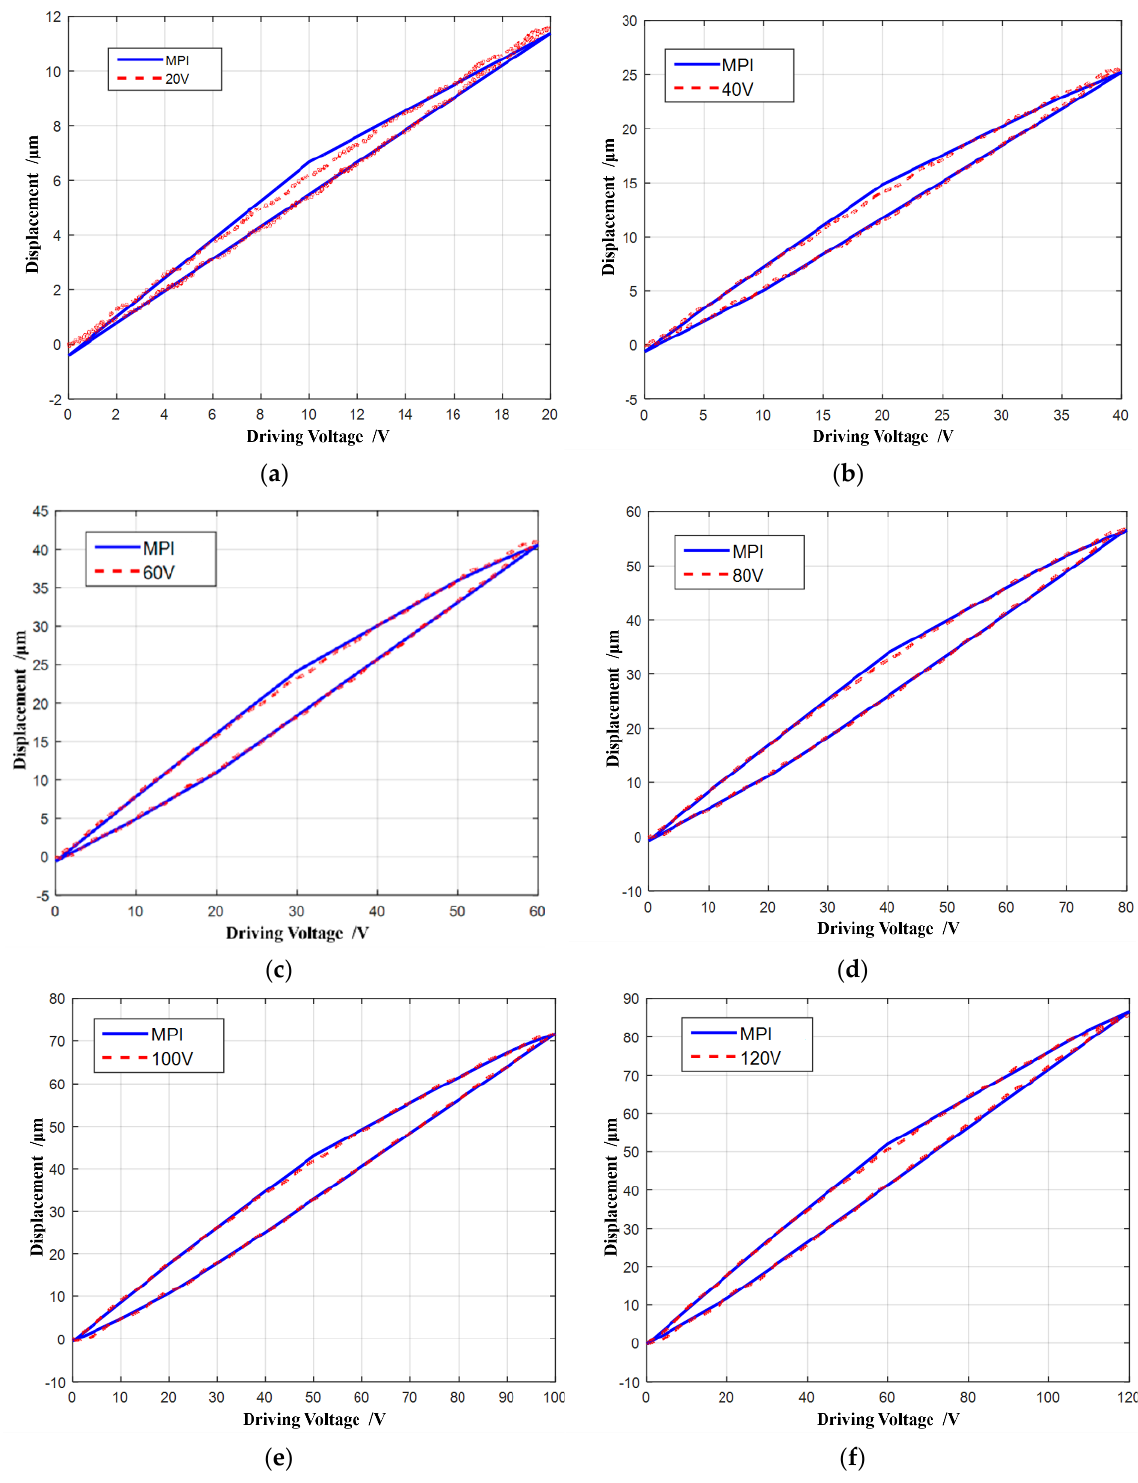
Figure 7. MPI model accuracies on variable voltage amplitudes. ( a ) 20 V; ( b ) 40 V; ( c ) 60 V; ( d ) 80 V; ( e ) 100 V; ( f ) 120 V; ( e ) 100 V; ( f ) 120